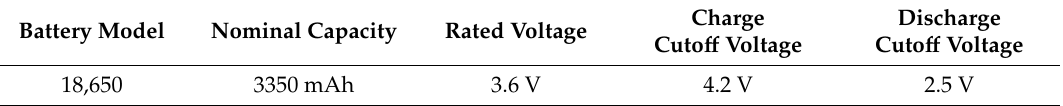
Figure 3. Battery test system. Table 1. Specifications of the Panasonic 18,650 ternary lithium-ion battery.